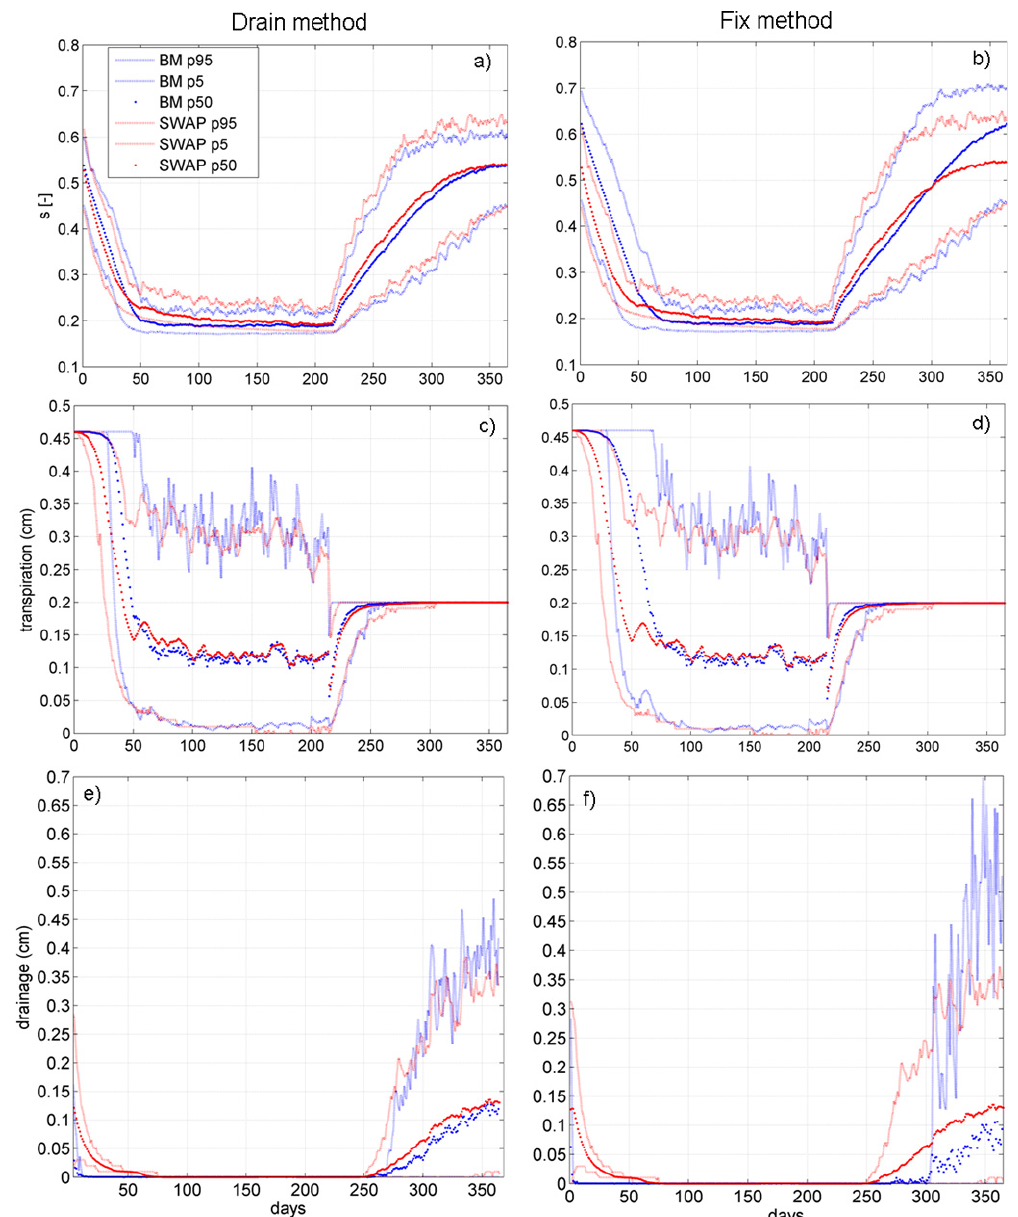
Fig. 9. Daily values of the 5th, 50th, and 95th quantiles for the loamy-sand soil over the entire hydrologic year as obtained from the 99 years of simulation run. Red lines refer to the SWAP model used as a reference, while blue lines refer to BM when field capacity is parameterized either with the drain -method (plots on the left-hand side) or with the fix -method (plots on the right-hand side): (a) and (b) refer to relative soil moisture content, s ; (c) and (d) refer to daily transpiration fluxes, T ; (e) and (f) refer to daily drainage (leakage) fluxes, L